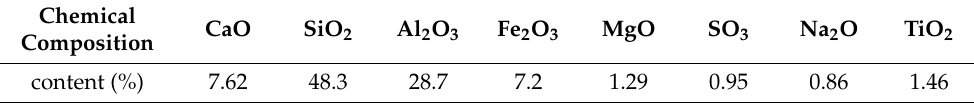
Table 3. Chemical composition of fly ash.